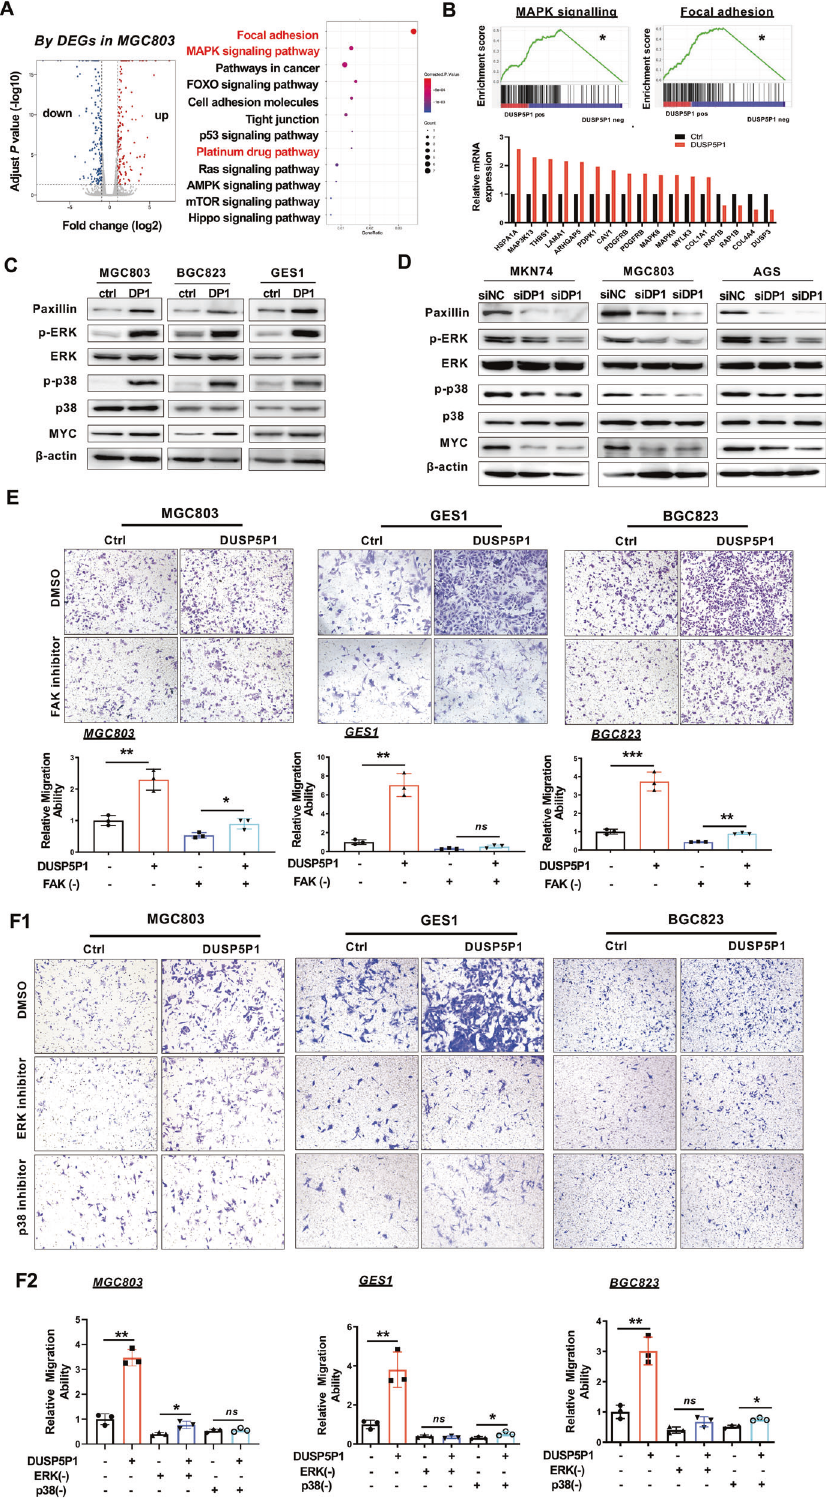
Fig. 3 DUSP5P1 activates focal adhesion and MAPK signaling pathway. A KEGG pathways enriched by differentially expressed genes affected by DUSP5P1. B Enriched differentially expressed genes of focal adhesion and MAPK signaling pathway. C DUSP5P1 re-overexpression promoted focal adhesion and MAPK pathway as evidenced by protein expression of factors in MAPK signaling pathway in AGS and GES1 cells by Western blot. D DUSP5P1 knockdown inhibited the MAPK pathway as evidenced by decreased protein expression of focal and MAPK signaling pathway. E Effect of DUSP5P1 on gastric cell migration in the presence or absence of FAK inhibitor (VS6063) in GES1, MGC803, and BGC823 cells (20 μ mol/L). F Effect of DUSP5P1on gastric cellmigration in thepresence orabsenceofMAPKinhibitor. EffectofDUSP5P1on gastric cellmigration in the presence orabsence of ERK inhibitor (PD98059) in GES1 (100 μ mol/L), MGC803 (150 μ mol/L) and BGC823 (150 μ mol/L); Effect of DUSP5P1 on gastric cell migration in the presence or absence of p38 inhibitor (BIRB796) in GES1, MGC803, and BGC823 (100 μ mol/L). * P <0.05, ** P <0.01, *** P <0.001, **** P